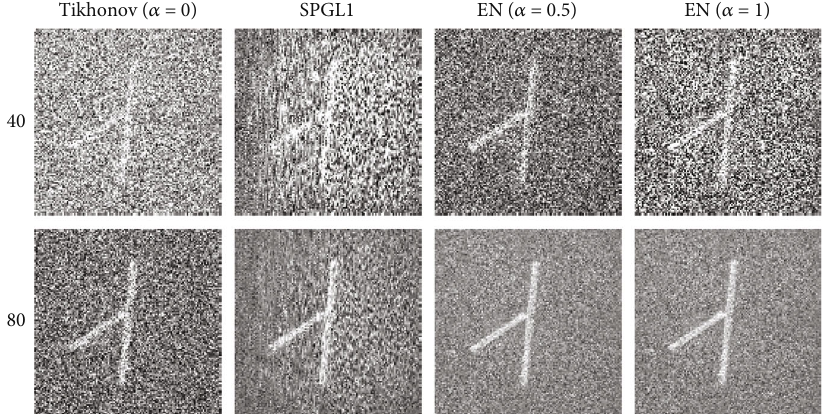
Figure 8: The results of agar phantom experiment. The fi rst and second rows are the reconstruction images of carbon absorption sample from 40-view and 80-view experimental data. The fi rst to fourth columns are the results of the Tikhonov ð α = 0 Þ , SPGL1, EN ð α = 0 : 5 Þ , and EN ð α = 1 Þ , individually.